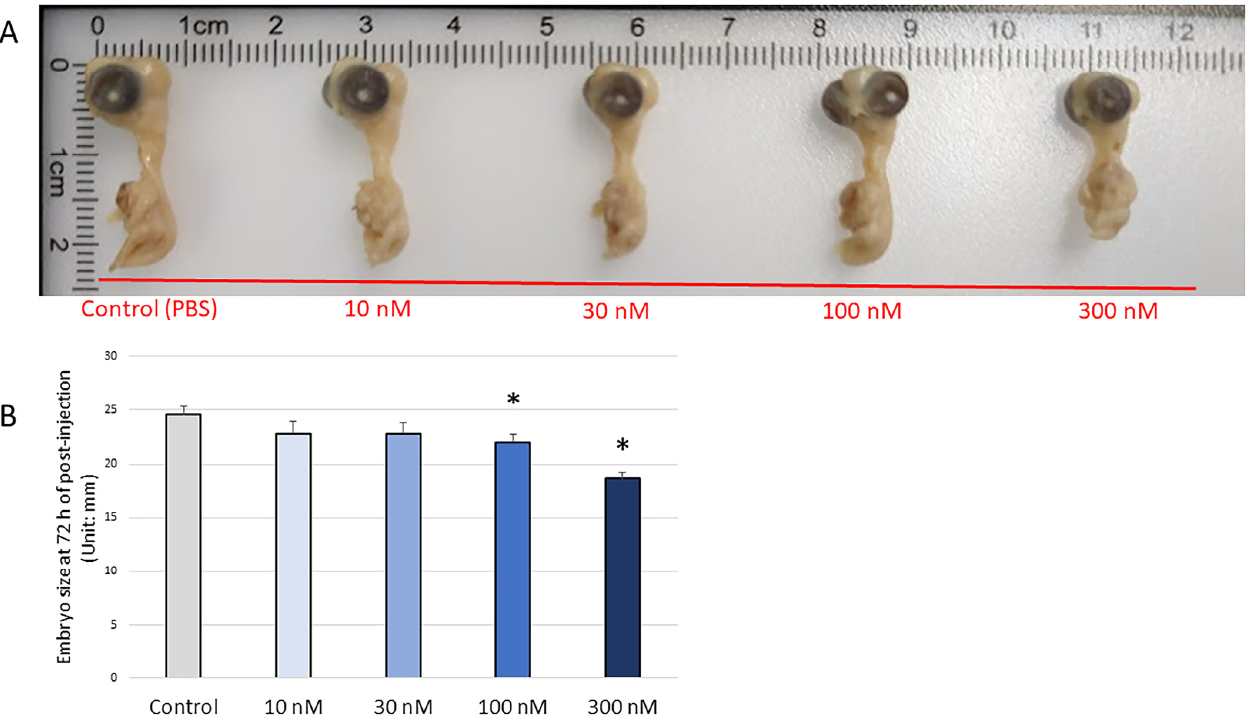
Figure 8. Embryos length is shorter for embryos microinjected with 100 nM and 300 nM H 2 O 2 compared to that of the PBS-injected controls. ( A ) Embryo samples at ED 7 (72 h post-injection). ( B ) The length of the embryos was measured with a digital caliper. Each value represents the mean ± SEM (N = 8). Treatments with * showed a significant difference compared with the control using the Dunnett’s test, p < 0.05.